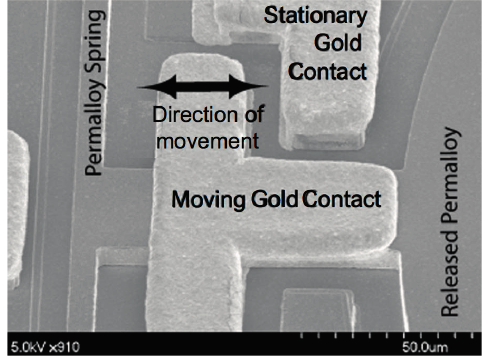
Figure 16. Glickman et al . SEM detail of the switch contact [136]. Reprinted with permission from [136]. Copyright 2011